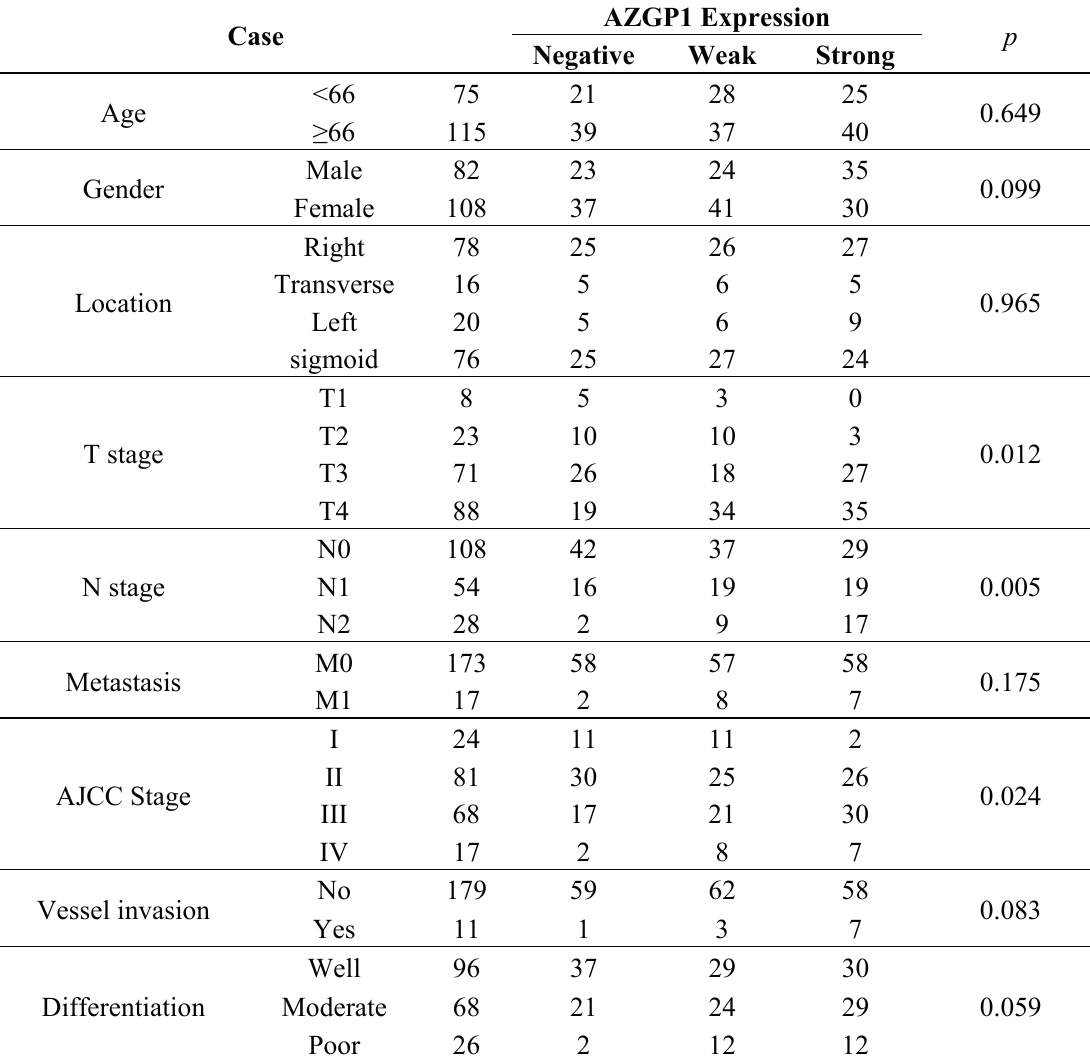
Table 1. Correlation between AZGP1 expression and clinicopathologic characteristics.